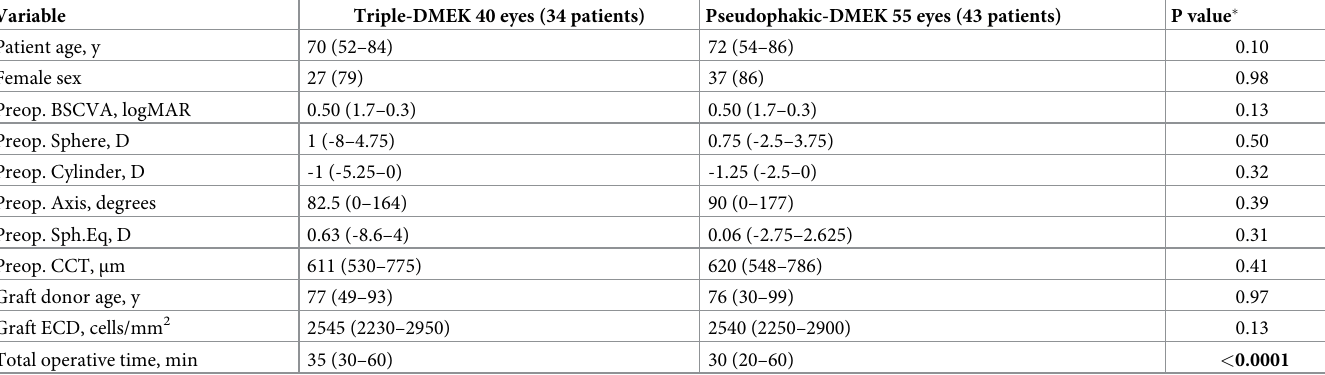
Table 1. Baseline and operative characteristics of the study groups.